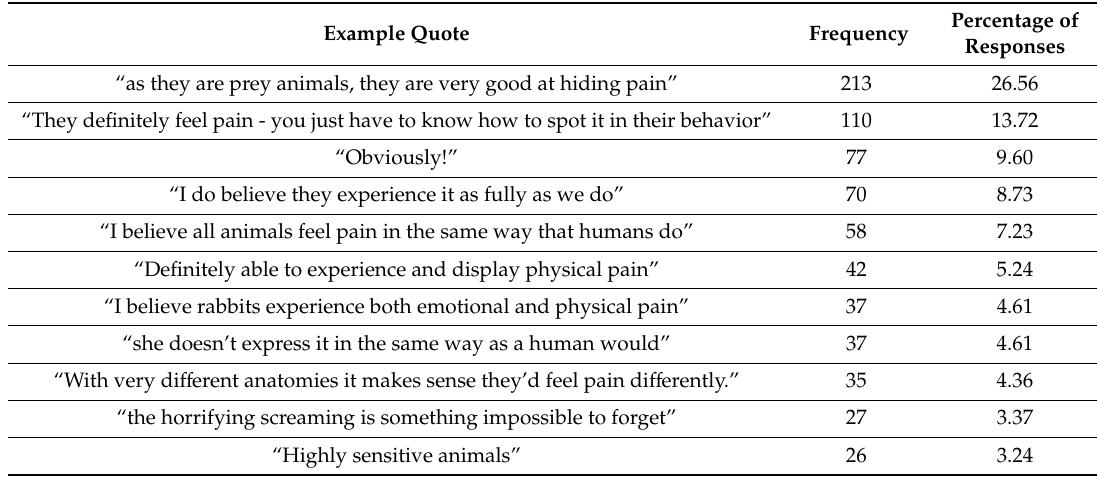
Table 8. Open-ended responses referring to rabbit pain. Statements included in the table if they were mentioned in over 3% of responses. n =